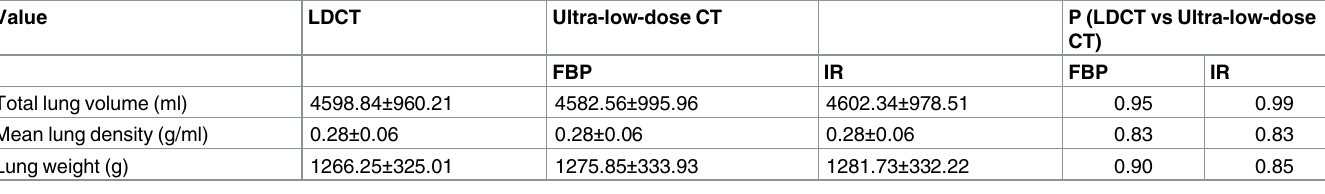
Table 3. Quantitative assessments with low-dose and ultra-low-dose CT.